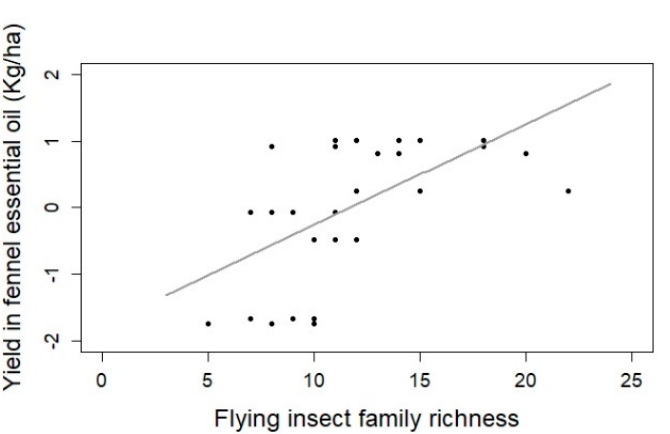
Figure 4. Essential oil yield increases with flying insect family richness-E = 0.1515, p -value < 0.01 (glmer with Gaussian family; N = 30).